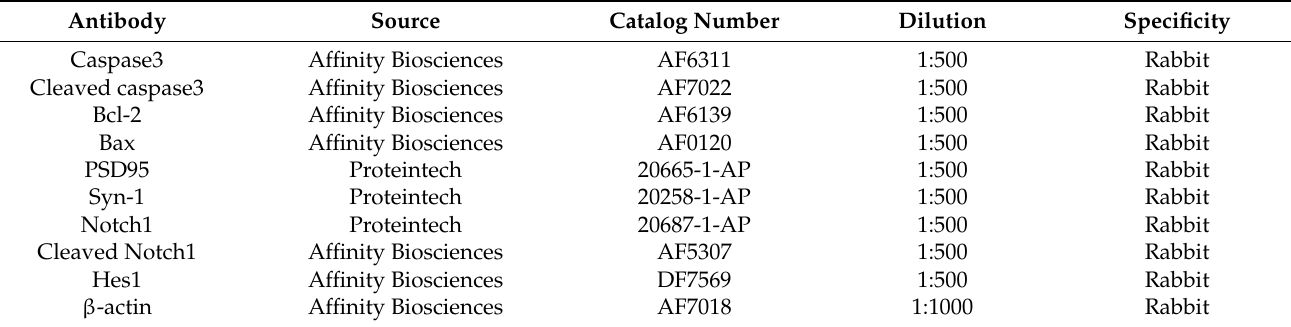
Table 2. Primary antibodies used in Western blotting.